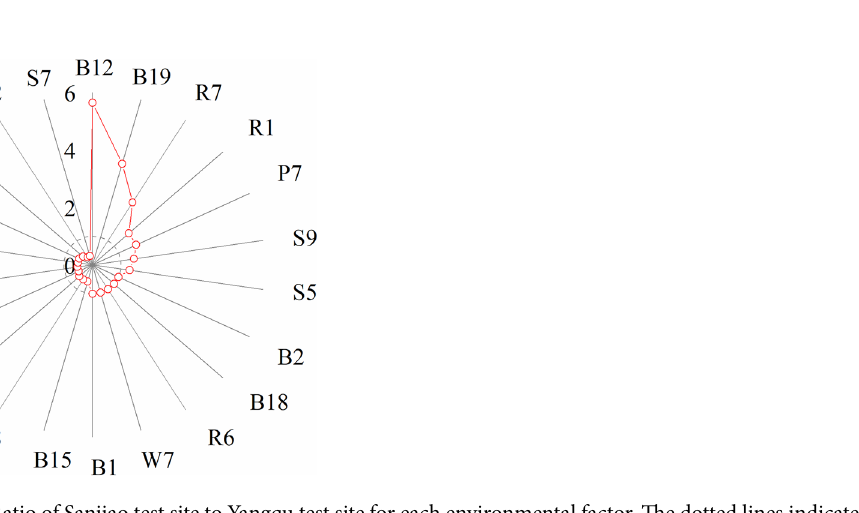
Figure 8. Ratio of Sanjiao test site to Yangqu test site for each environmental factor. The dotted lines indicate the